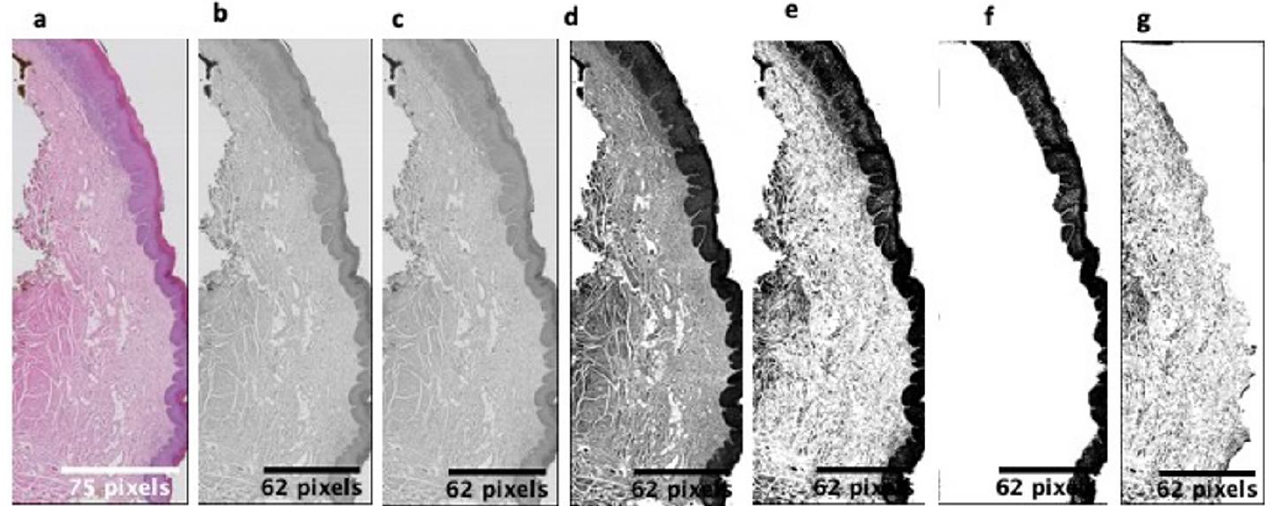
Figure 1. Image treatment process and level separation: ( a ) original image, ( b ) 8-bit image transformation, ( c ) threshold 128, ( d ) erosion and dilation, ( e ) make binary, ( f ) epithelium, cropped, and ( g ) connective tissue, cropped.